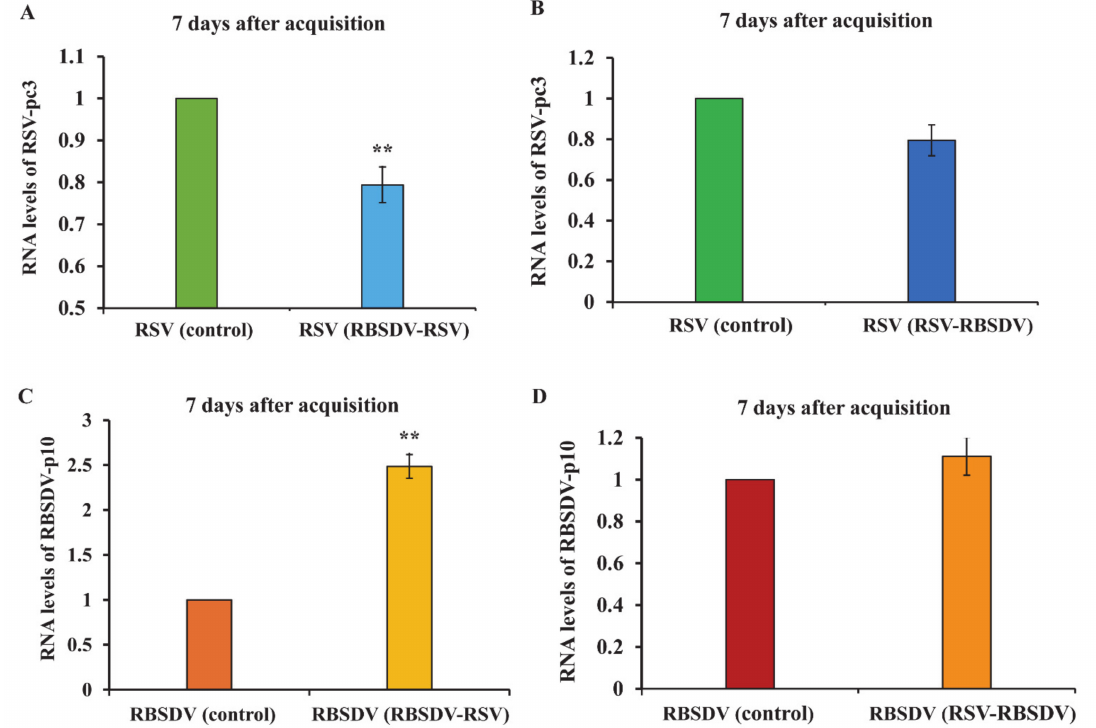
Figure 4. Relative RNA levels of RSV-pc3 and RBSDV-p10 at 7 days after acquisition access of RBSDV-RSV and RSV-RBSDV groups. RSV-pc3 relative RNA levels in RBSDV-RSV group ( A ) and RSV-RBSDV group ( B ); RBSDV-p10 relative RNA levels in RBSDV-RSV group ( C ) and RSV-RBSDV group ( D ). Three biological replicates were performed; each had three technical replicates. Asterisks (**) indicate a significant difference at p < 0.01 in Tukey’s HSD test with 95%